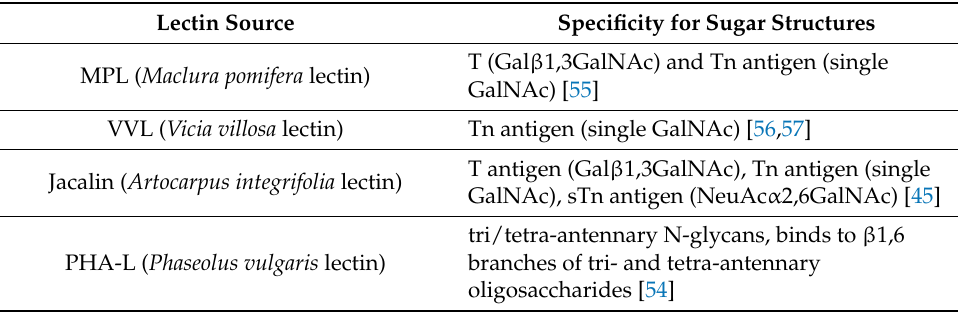
Table 6. Specificity of the lectins used in the study. Lectin Source Specificity for Sugar